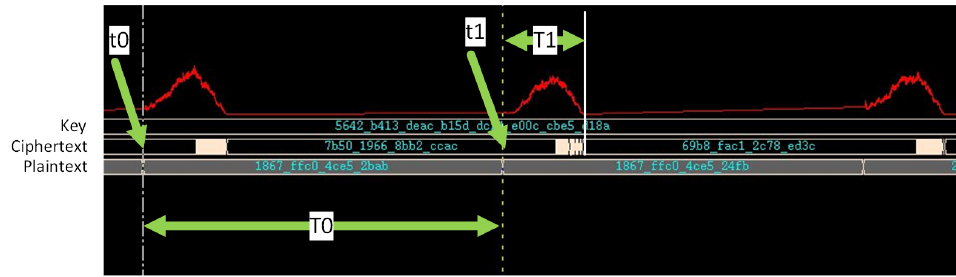
Figure 3. Simulation waveform for P 0,7 and P 1,7 .